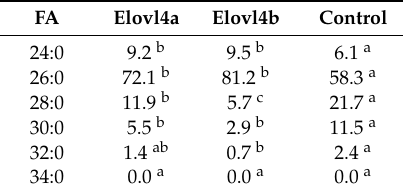
Table 2. Functional characterization of Solea senegalensis Elovl4 elongases: role in the biosynthesis of very long-chain saturated fatty acids (FA).